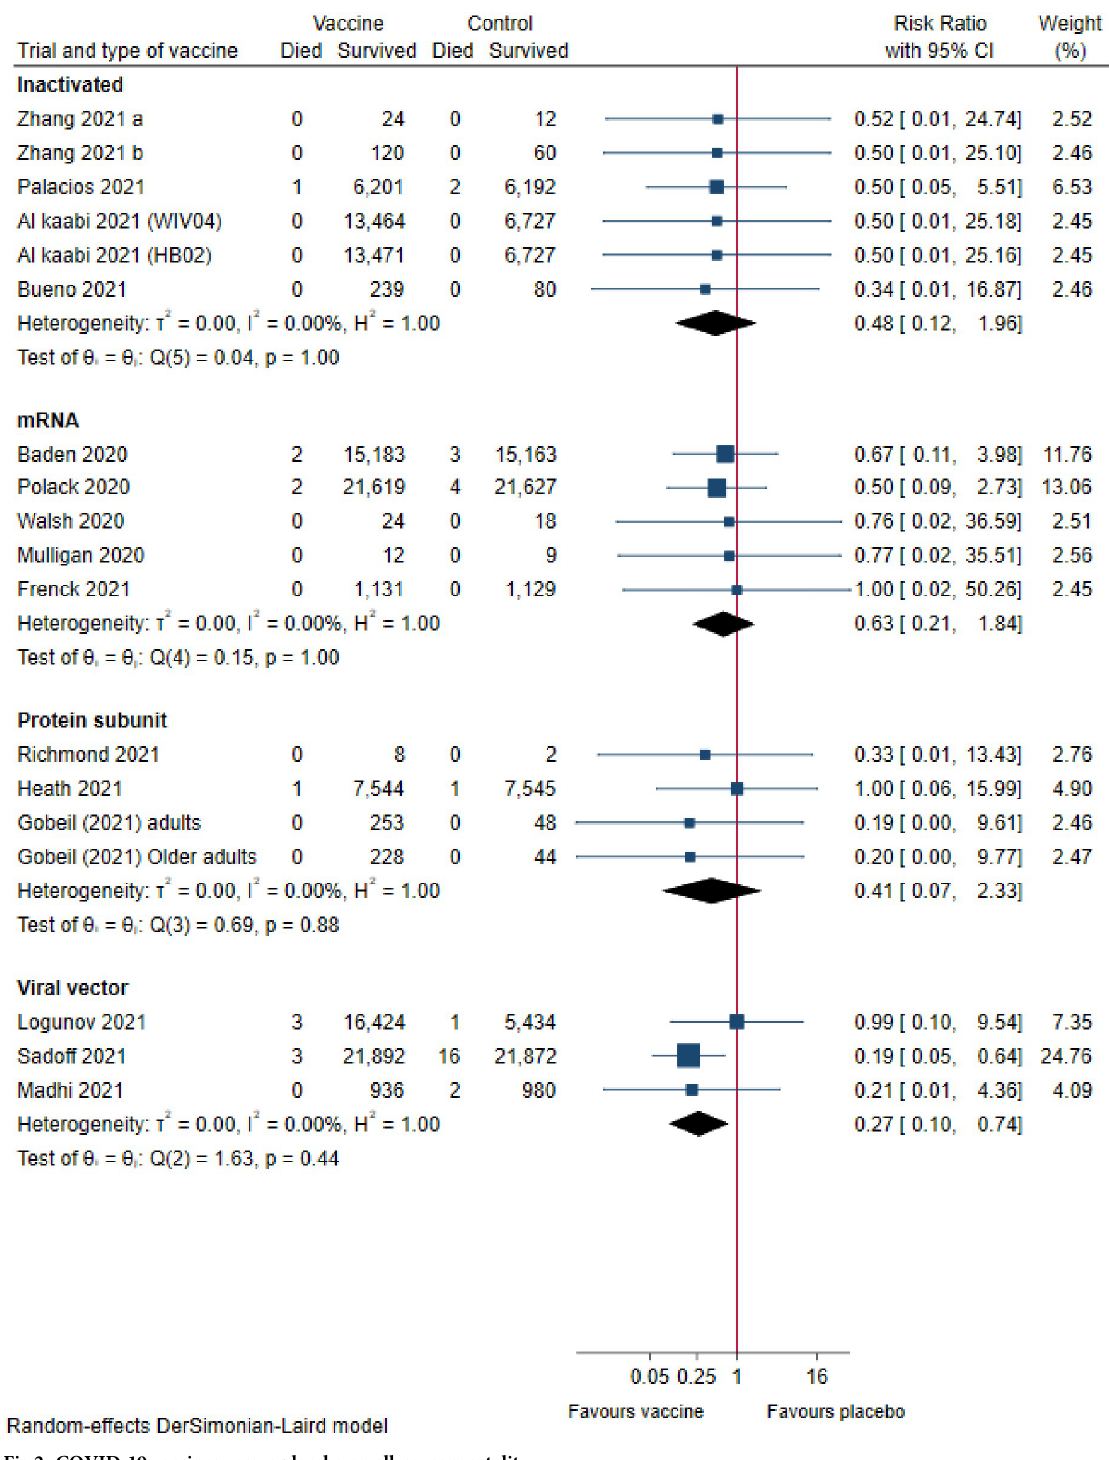
PLOS ONE | https://doi.org/10.1371/journal.pone.0260733 January 21,